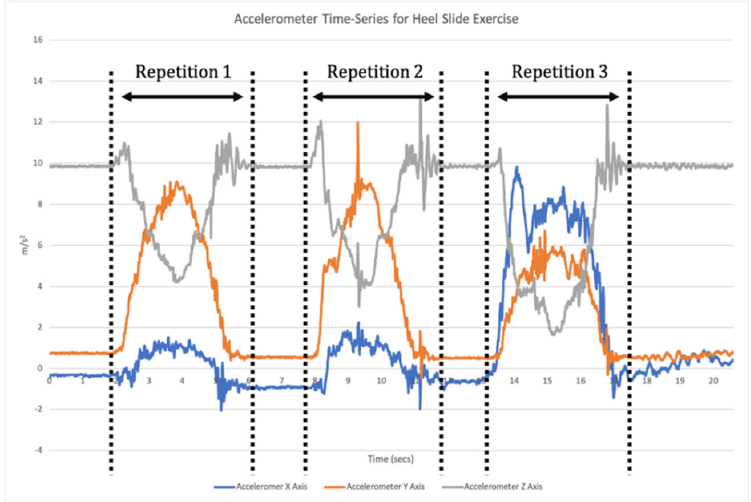
Figure 1. An example of a correctly segmented time-series of triaxial accelerometer data.